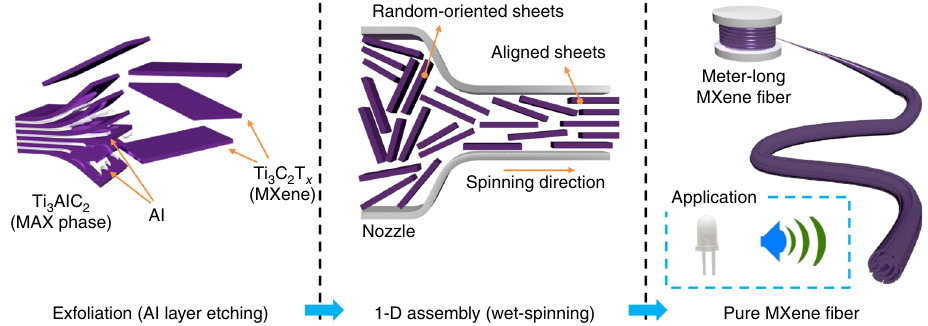
Fig. 1 Schematic illustration of the reconstruction of MXene single layers into MXene fi bers. Ti 3 AlC 2 was exfoliated to Ti 3 C 2 T x by etching the Al layer. The MXene was highly concentrated in the aqueous dispersion and assembled into a fi ber, which was aligned in the axial direction by the wet-spinning process. The obtained pure MXene fi ber was used for electric energy and signal transfer applications.